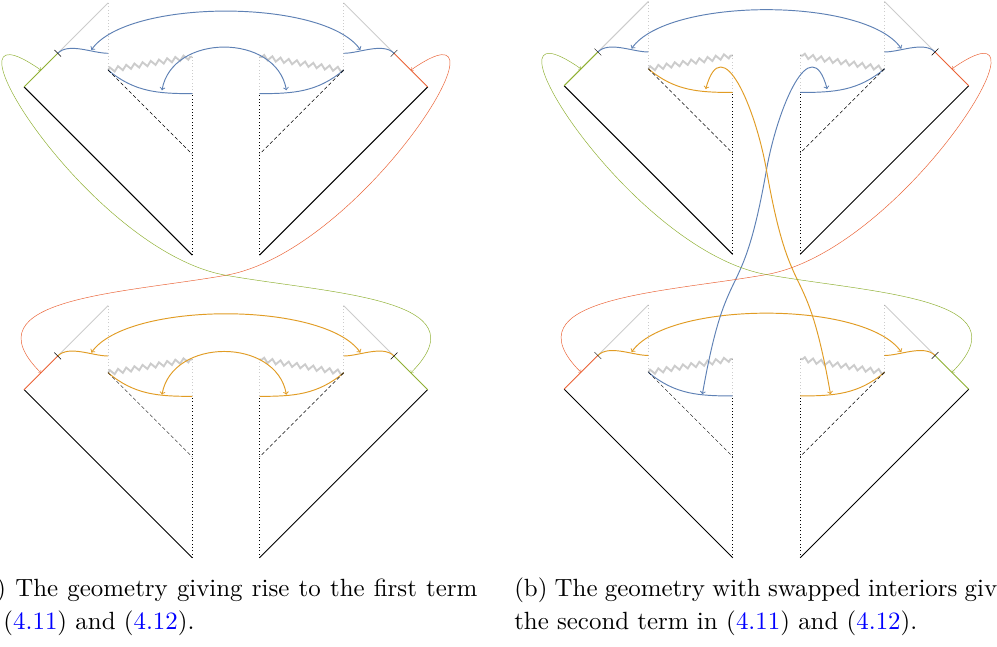
(a) The geometry giving rise to the first term in (4.11) and (4.12). Figure 13. The two PS wormholes contributing to the computation of Tr tation value of a swap operator acting on I u for two sets of